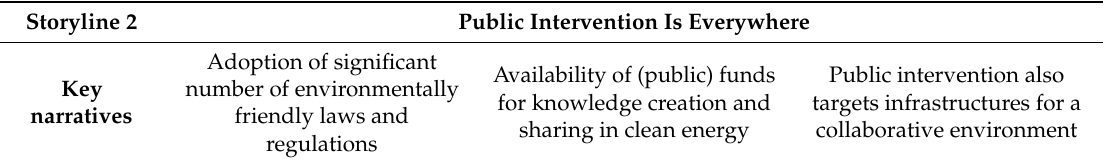
Table 4. Overview of Storyline 2 on legitimizing public